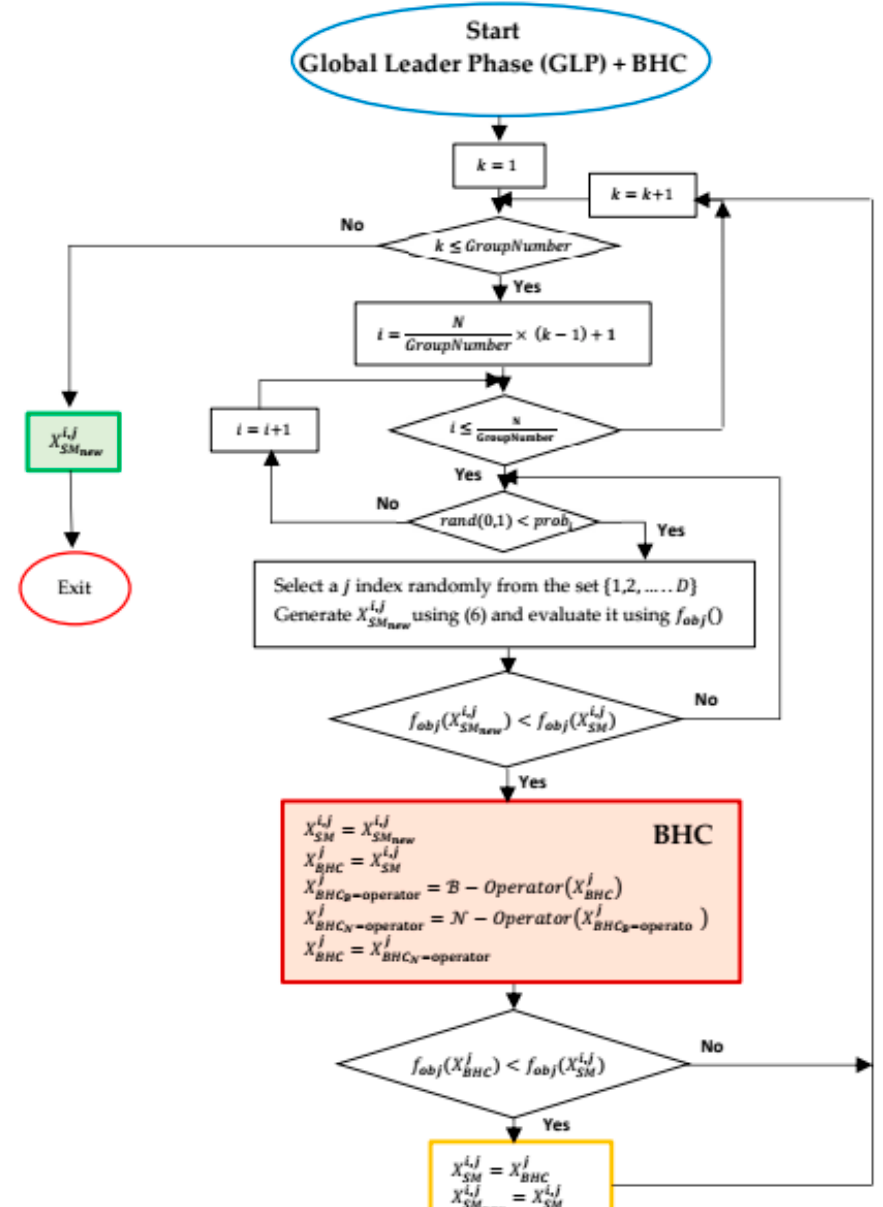
Figure 4. Flowchart of the Global Leader Phase (GLP) based on BHC.